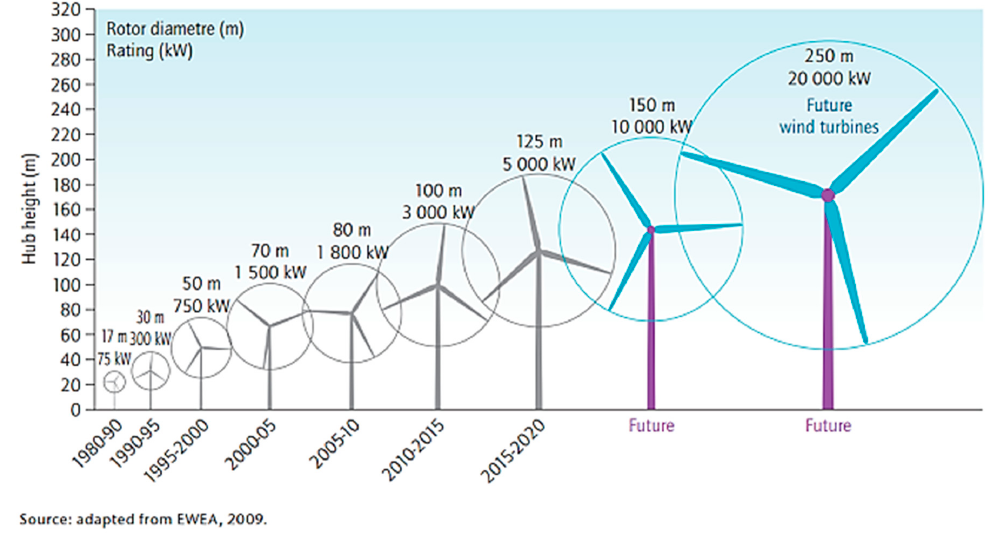
Figure 4. Growth in size of wind turbines since 1980 and future prospects [10].